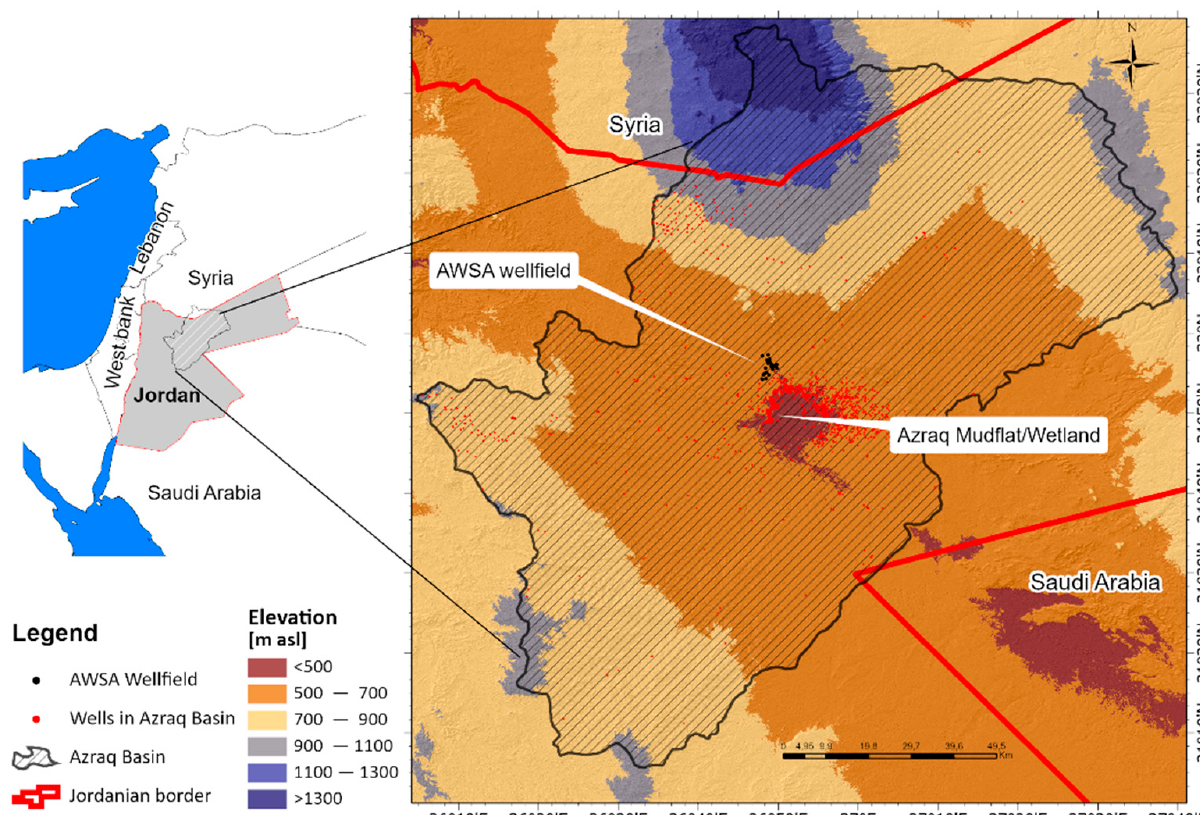
Figure 1. The elevation and extension of the Azraq Basin (the elevation unit is meters above sea level (m asl)).